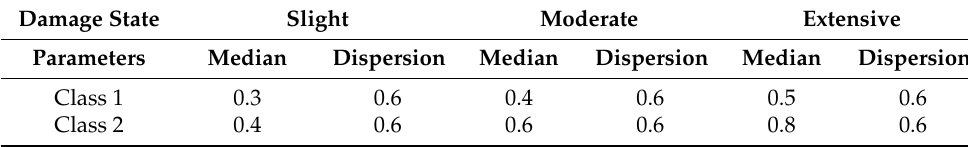
Table 3. Classification of bridges in different network cases.